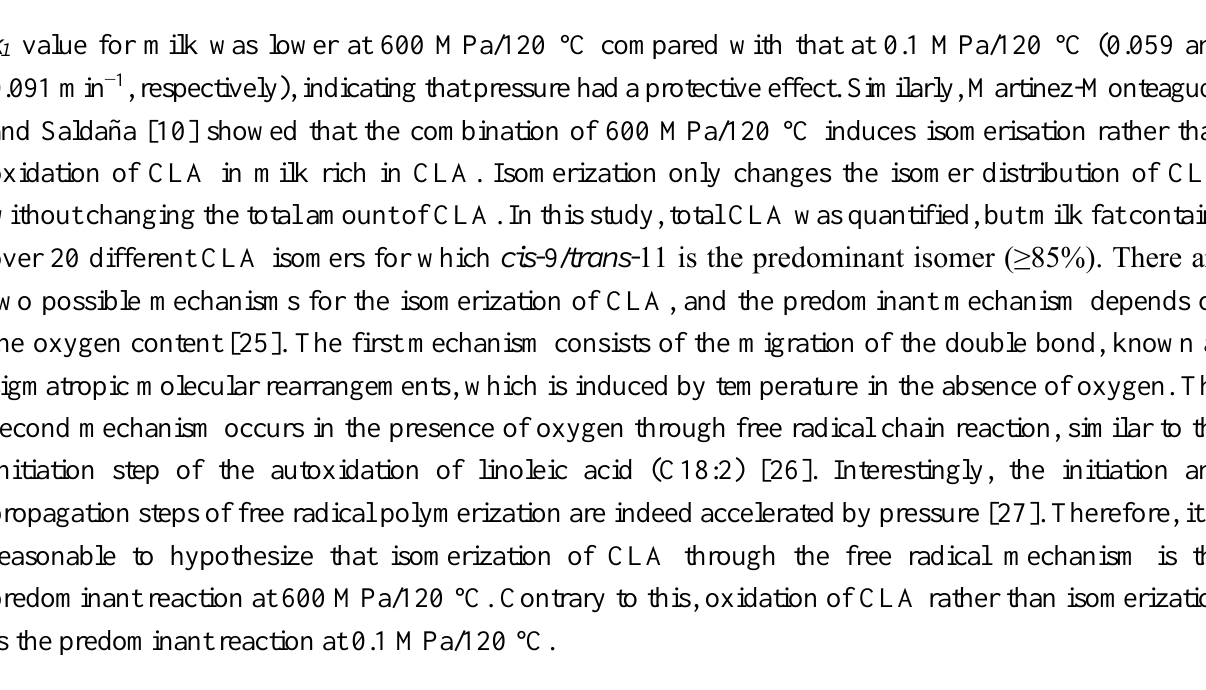
Table 1. Oxidation rate constant ( k 1 , min −1 ) of CLA-enriched milk treated at 120 °C and either 600 or 0.1